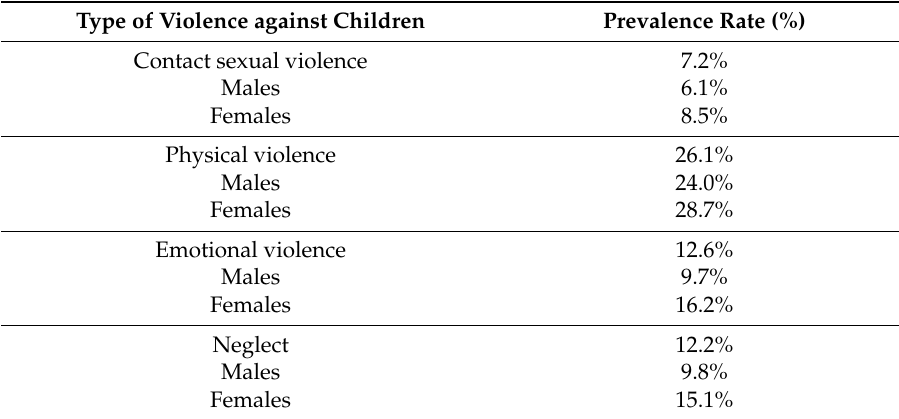
Table 2. Prevalence of violence against